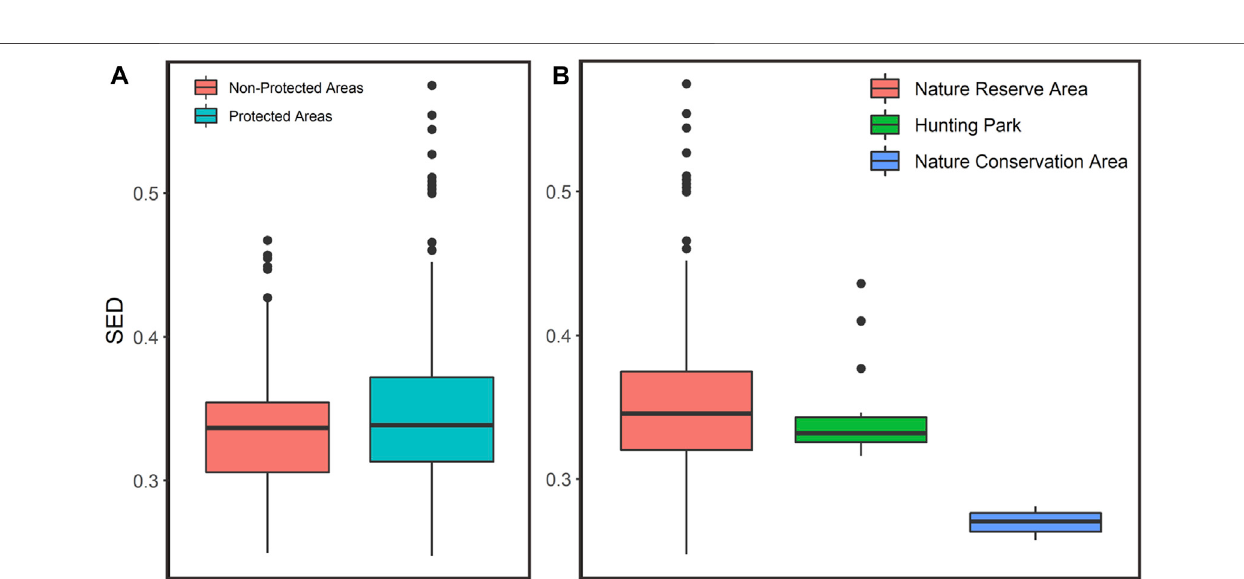
FIGURE 3 | Local climate exposure variation within protected and non-protected areas (A) and different protected area types (B) in the Leuser Ecosystem.